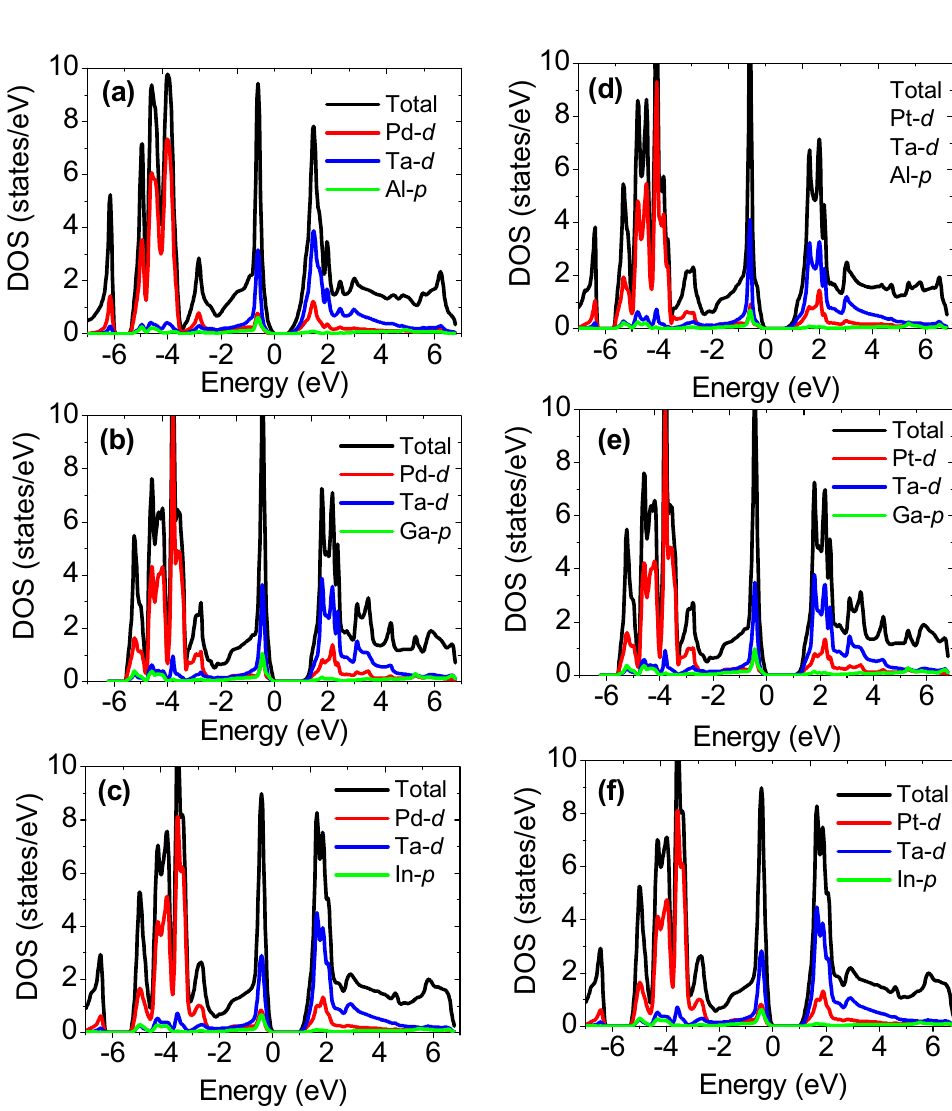
Figure 4. Projected (pDOS) density of states of XTaZ